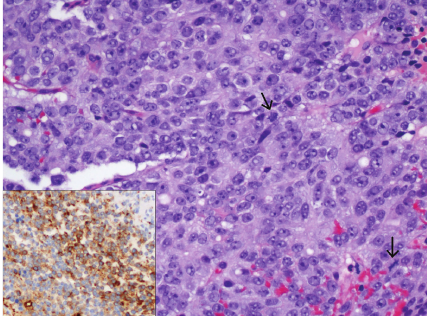
Figure 2: Metastasis in penile urethra: tumour composed of solid sheets or single cells with prominent nucleoli and several mitotic figures (arrows) (hematoxylin and eosin, 200x). Prostate specific